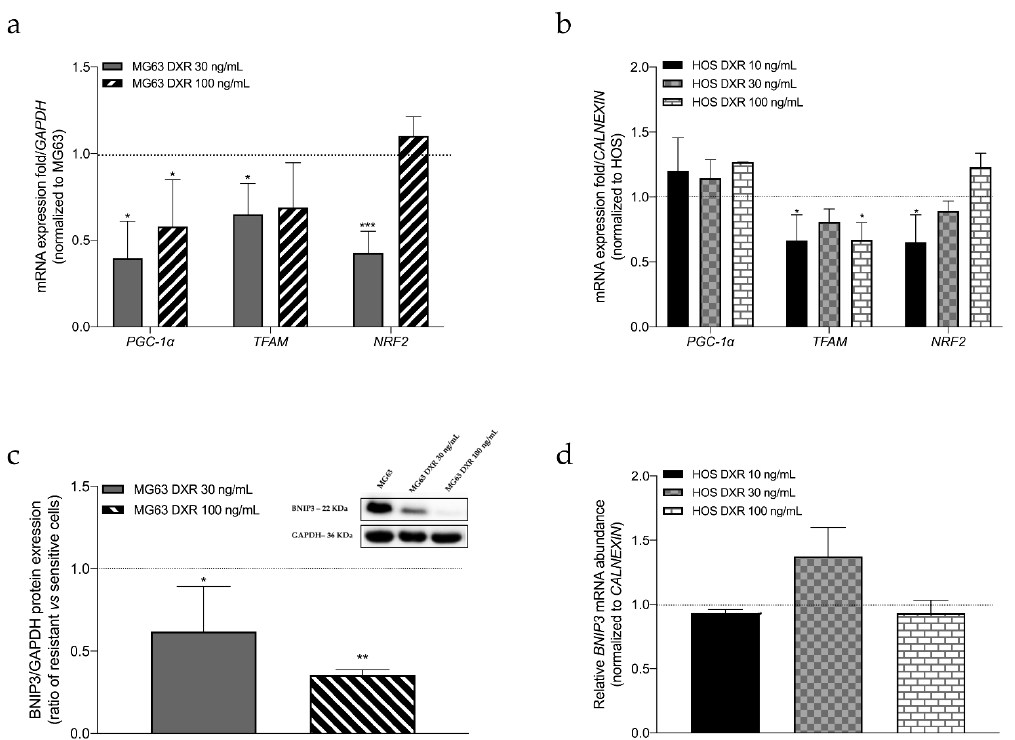
Figure 3. ( a ) Relative mRNA expression levels of genes related to mitochondrial biogenesis in MG63, MG63 DXR 30 ng/mL, and MG63 DXR 100 ng/mL cells. mRNA levels of all genes are nor- malized to GAPDH . The horizontal dotted line refers to normalized untreated cells. ( b ) Relative mRNA expression levels of genes related to mitochondrial biogenesis in HOS, HOS DXR 10 ng/mL, HOS DXR 30 ng/mL, HOS DXR 100 ng/mL cells. mRNA levels of all genes are normalized to CALNEXIN . The horizontal dotted line refers to normalized untreated cells. ( c ) Representative images and graphical quantification of protein expression of BNIP3, normalized to GAPDH in MG63, MG63 DXR 30 ng/mL, and MG63 DXR 100 ng/mL cells. The horizontal dotted line refers to normalized untreated cells. The uncropped Western Blot images can be found in Figure S3. ( d ) Relative mRNA expression levels of BNIP3 in HOS, HOS DXR 10 ng/mL, HOS DXR 30 ng/mL, HOS DXR 100 ng/mL cells. mRNA levels of all genes are normalized to CALNEXIN . The horizontal dotted line refers to normalized untreated cells. Data represent media ± SD of three different experiments. * p < 0.05, ** p < 0.01, *** p < 0.001, resistant “vs.” sensitive cells.